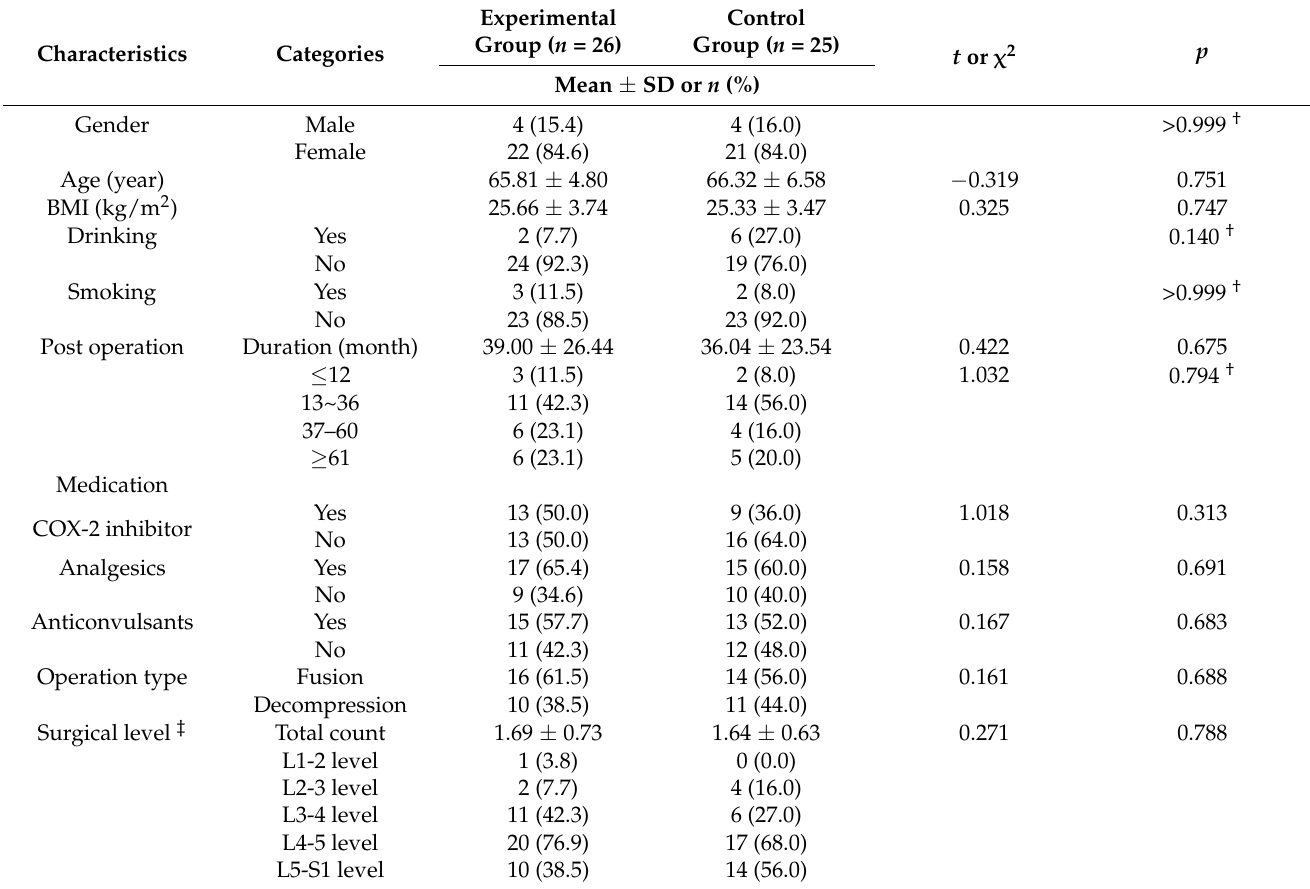
Table 1. Homogeneity of characteristics of participants ( n = 51).